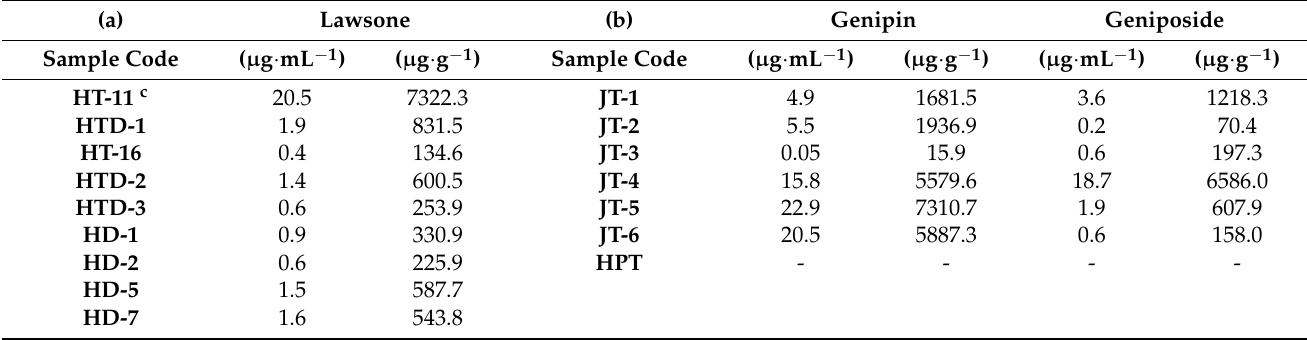
Table 3. Analysis of targeted compound in samples. ( a ) Henna samples. ( b ) Jagua samples.